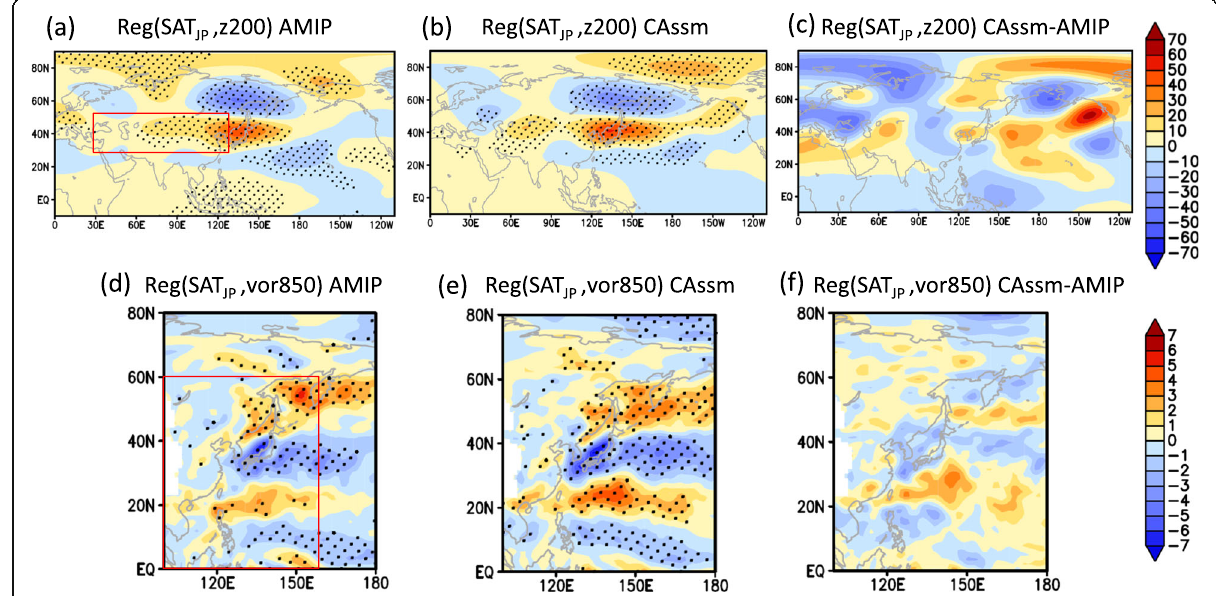
Fig. 4 Regression maps of 200 hPa geopotential height (z200; upper panels) and 850 hPa relative vorticity (vor850; lower panels) onto SAT JP obtained from the 350 year (10 members from 1980 to 2014) ensemble simulations using a , d AMIP and b , e CAssm experiments. Differences between CAssm and AMIP experiments are shown for the regressions of c z200 and f vor850, respectively. The red boxes show the target areas of EOF analysis for a Silk Road and d PJ pattern indices,